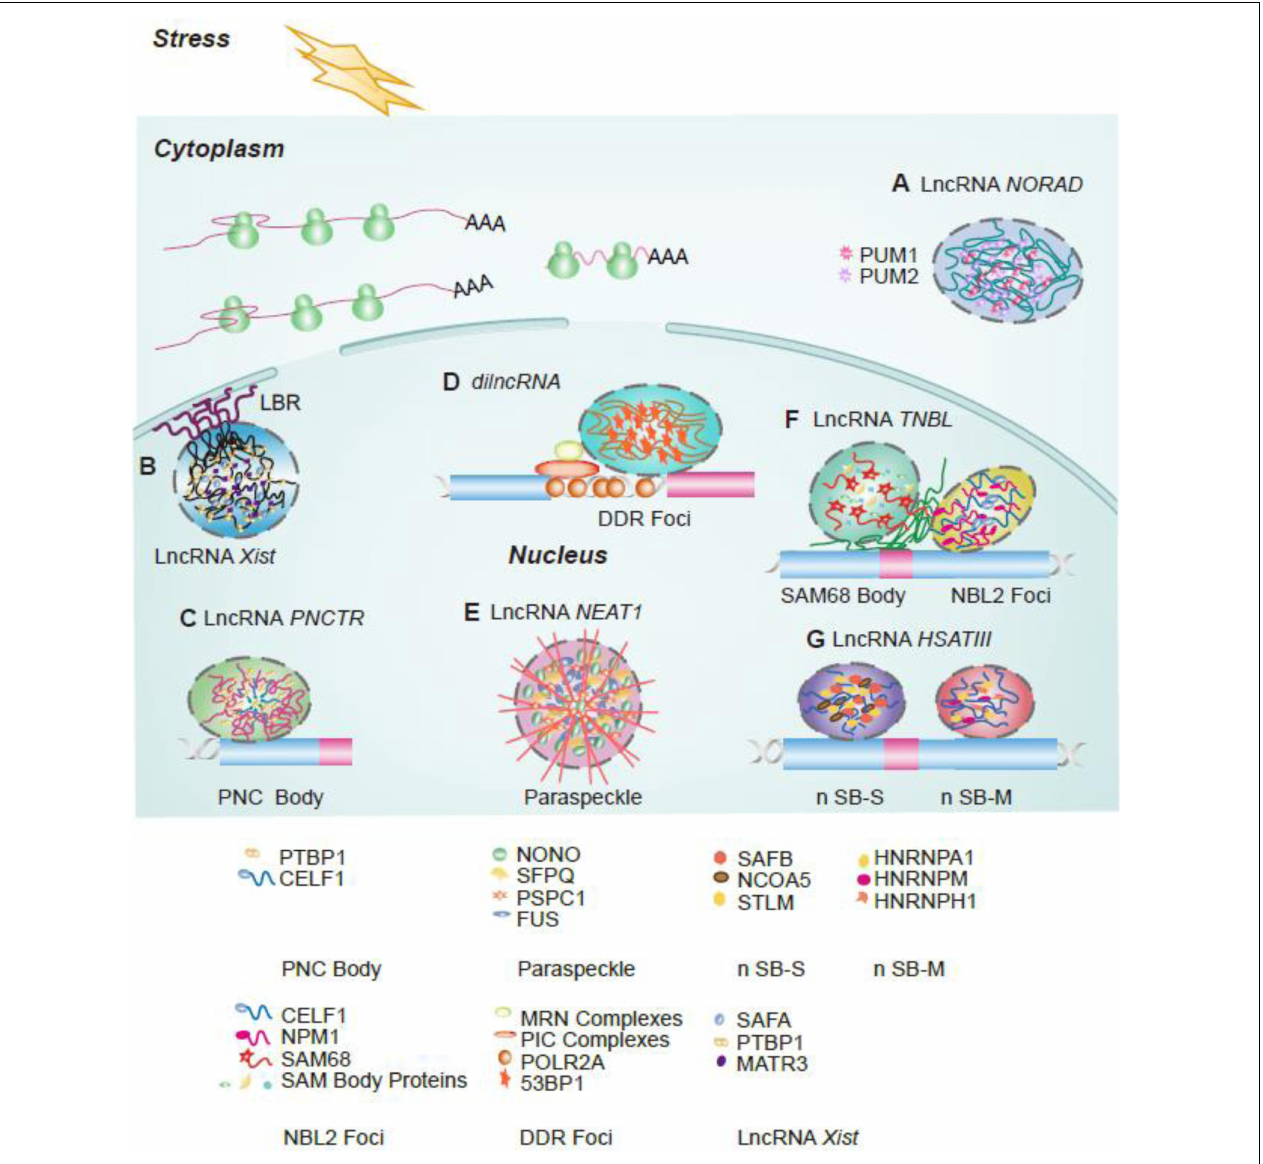
FIGURE 1 | The graphical abstract of phase-separation related LncRNAs involved in cellular function. (A) LncRNA NORAD functions as a multivalent binding platform for PUM1/2 proteins in cytoplasm; (B) LncRNA Xist mediates X chromosome silence and subsequently drives interaction between inactivated X chromosome and Lamin-B receptor (LBR); (C) LncRNA PNCTR sequesters PTBP1 in the perinucleolar compartment (PNC) and modulates splicing regulation function of PTBP1 protein; (D) DilncRNA synthesized at DSB foci and coordinates DDR proteins to promote the formation of DDR foci to response to DBS; (E) LncRNA NEAT1 functions as scaffolds to recruit CARM1, PSPC1, and p54nrb proteins to regulate cell differentiation and embryo development in paraspeckle; (F) LncRNA TNBL is accumulated as a perinucleolar aggregate at NBL2 loci and close to SAM68 body and is involved in genome organization, splicing